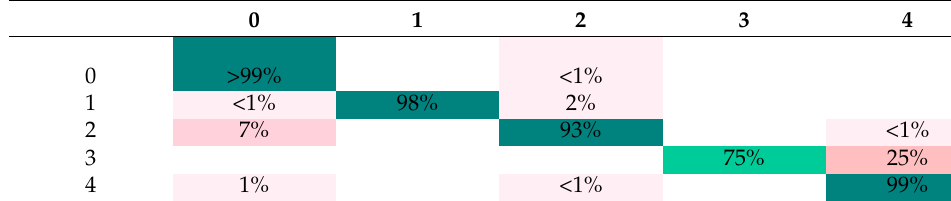
Figure 23. Overview of the experimental vibration response-only test [119]. Table 7. A confusion matrix for the k-NN algorithm [119].